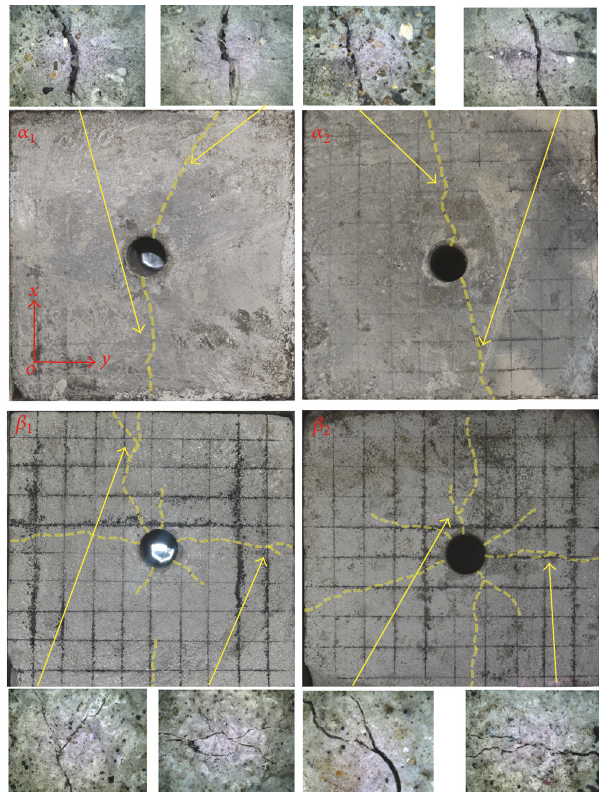
Figure 3: Photos of the surface cracks forms 𝛼 and 𝛽 group.